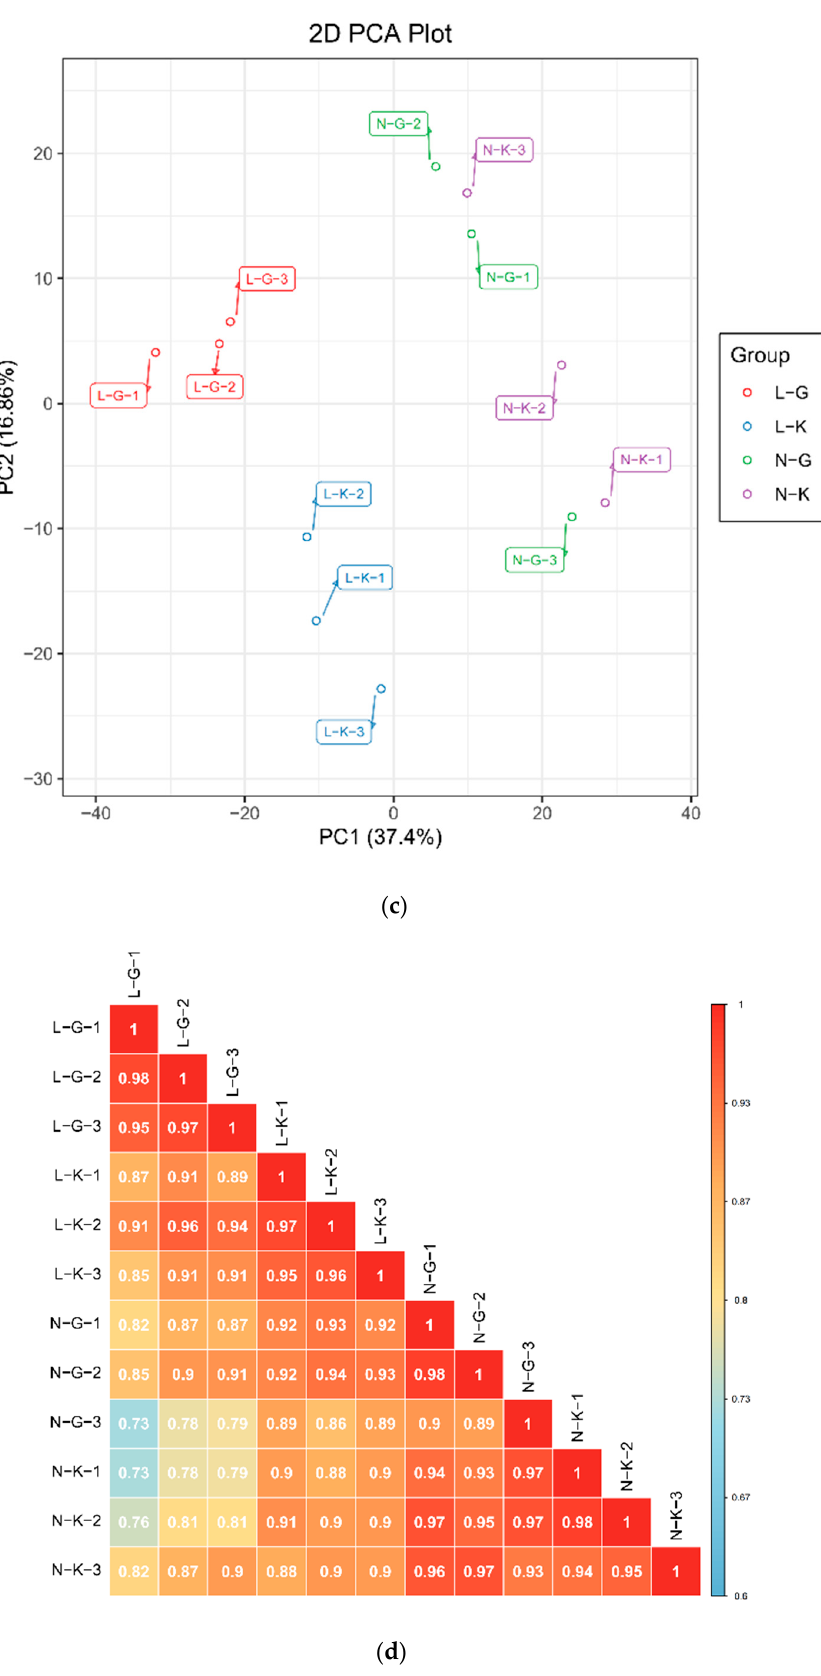
Figure 1. Tic overlap diagram of quality control (QC) sample mass spectrometry detection: ( a ) positive ion mode, ( b ) negative ion mode, ( c ) principal component analysis (PCA) score diagram of all samples, and ( d ) correlation diagram between samples. Note: PC1 represents the first principal com- ponent, PC2 represents the second principal component, and the percentage represents the inter- pretation rate of the principal component to the data set; each point in the figure represents a sam- ple, and the samples of the same group are represented by the same color.